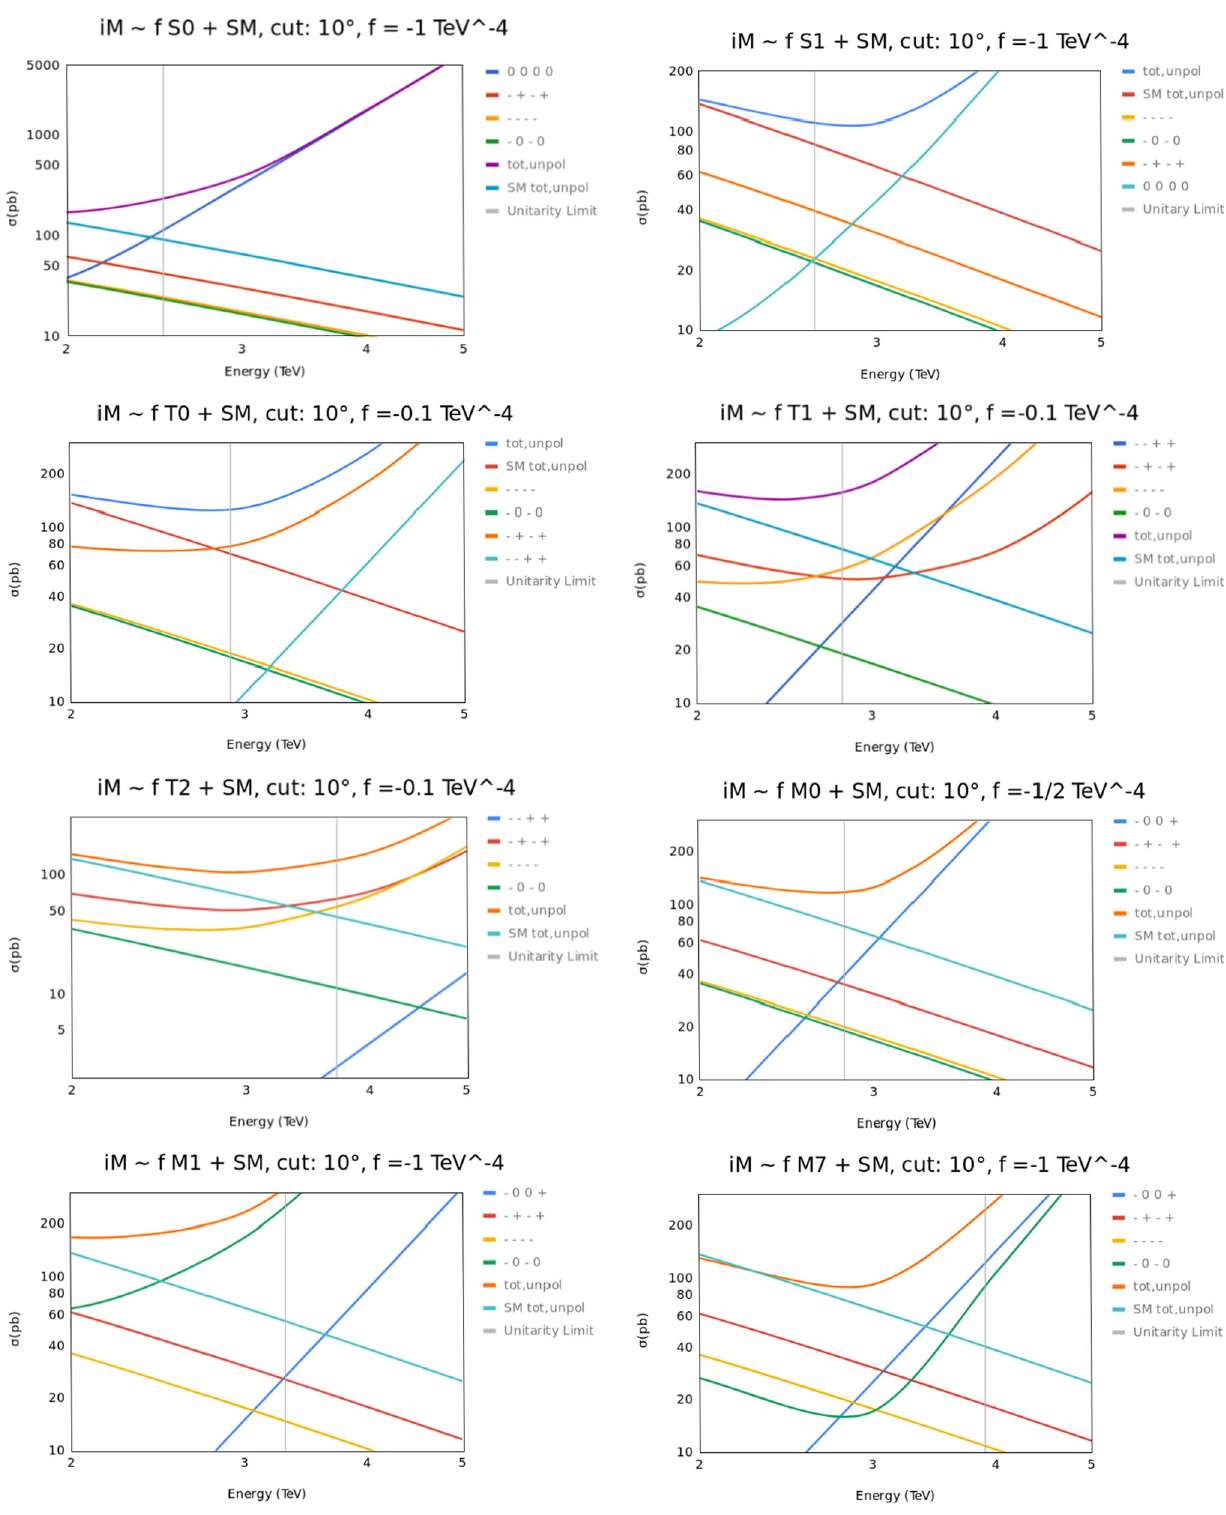
Fig. 7 Contributionsofthepolarizedcrosssections(multiplicitytaken into account) as functions of the center-of-mass collision energy √ s , in TeV) for chosen values of f i < 0. The remaining ( E CM ≡